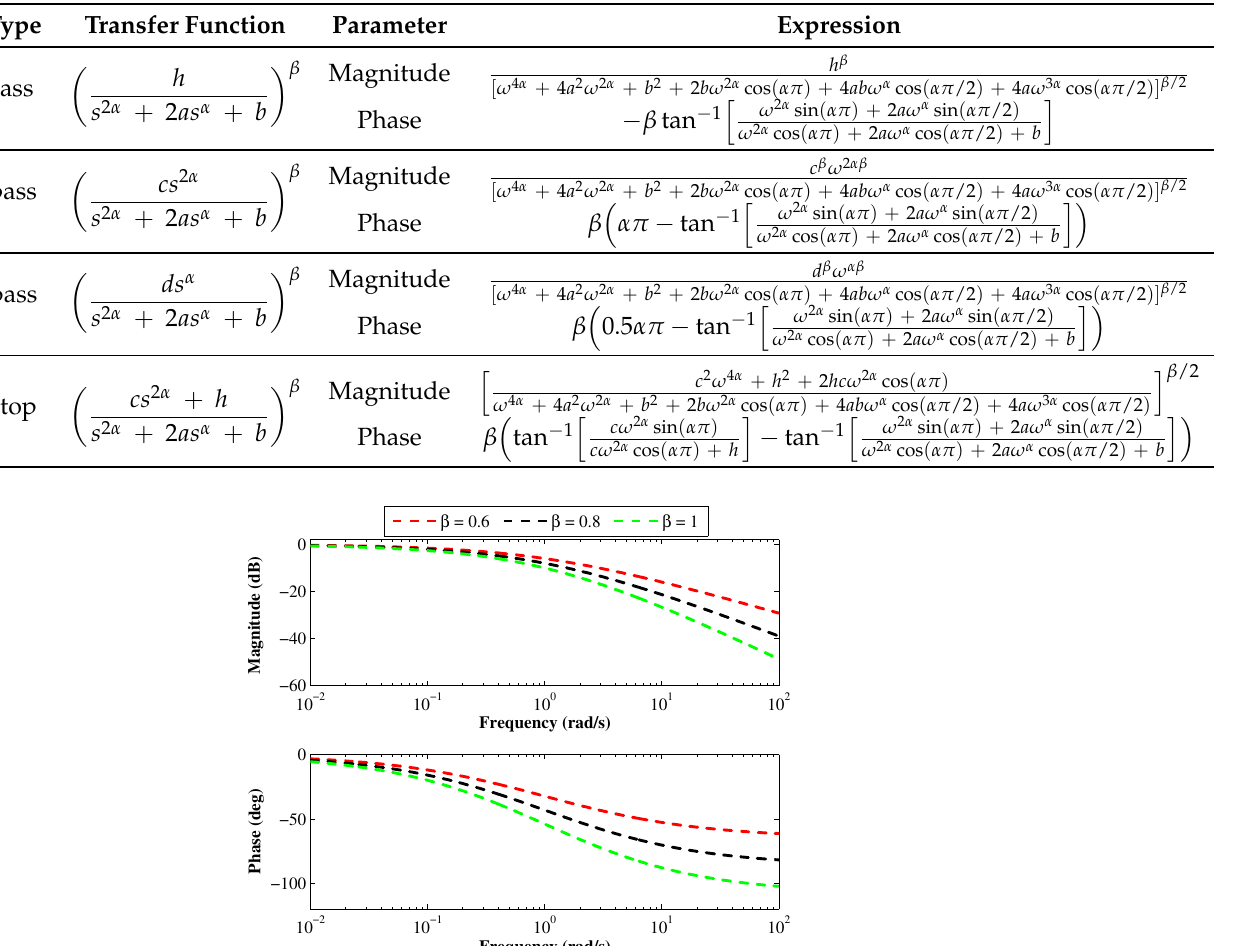
Table 1. Transfer function, magnitude, and phase of the proposed theoretical filters.